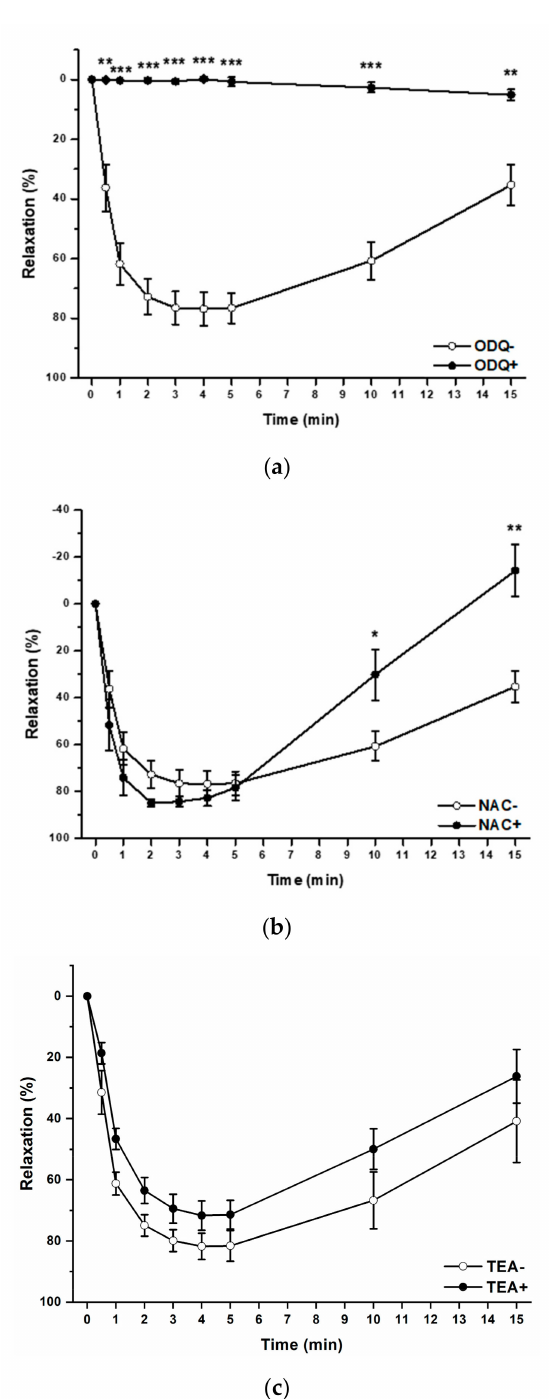
Figure 5. The possible mechanism of the vasorelaxation induced by H 2 S / GSNO products. The comparison of the relaxation (%) to H 2 S / GSNO products (0.5 µ M) after soluble guanylyl cyclase inhibitor (ODQ; 10 µ M; a ), HNO scavenger (NAC; 1 mM; b ) and non-specific K + channel inhibitor (TEA, 1 mM; c ). Values are mean ± S.E.M. * p < 0.05; ** p < 0.01; *** p < 0.001 with respect to the value of the H 2 S / GSNO products